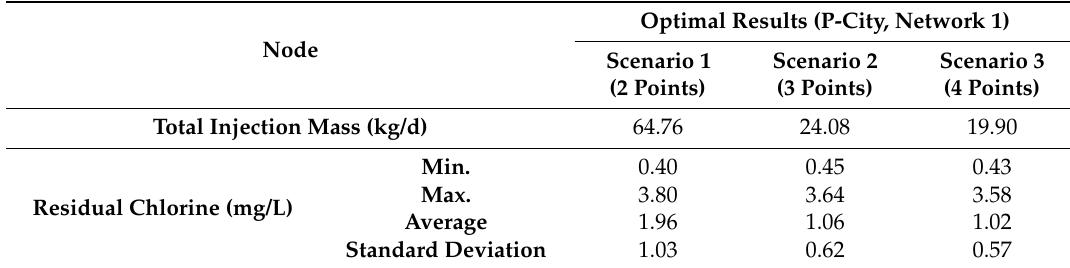
Table 3. Hydraulic and water quality simulation results for optimal